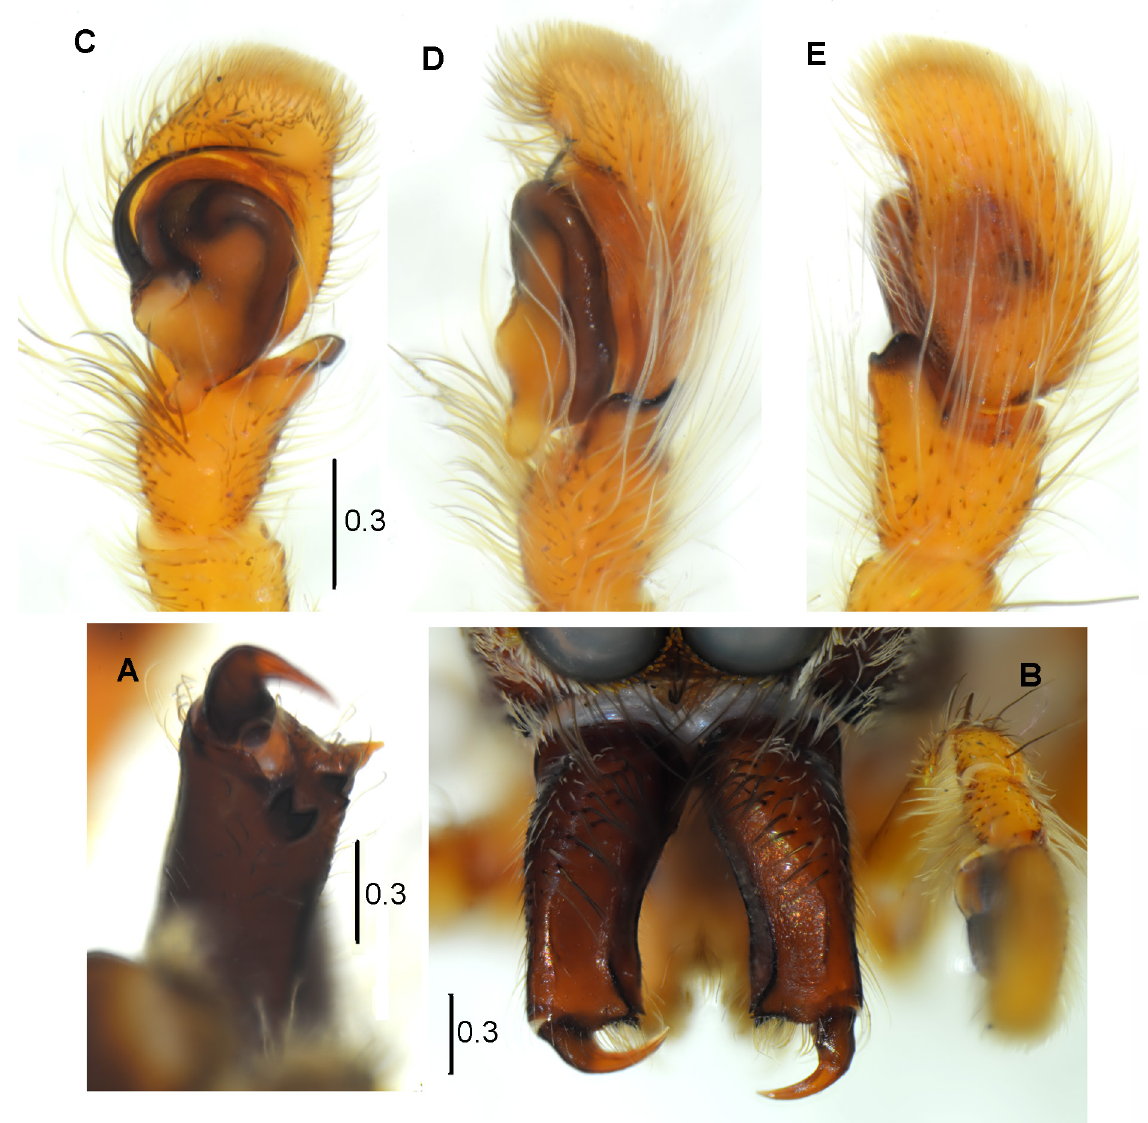
Fig. 73. Tusitala cornuta sp. nov., paratype, ♂ (MNHN). A . Chelicera, ventral view. B . Chelicerae, frontal view. C . Palpal organ, ventral view. D . Palpal organ, lateral view. E . Palpal organ, laterodorsal